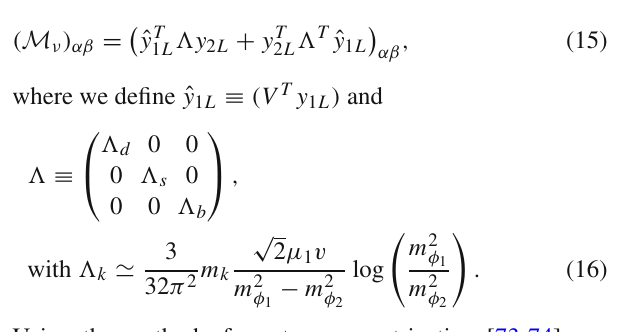
Fig. 1 Feynman diagram of Majorana neutrino masses generation at one-loop level ˜ S 1 − R 2 contribution is dominant ( μ 1 (cid:12) μ 2 , λ 13 v ), the neu- trino mass matrix can be written